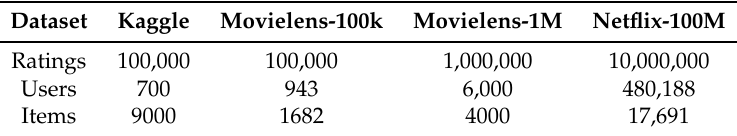
Table 2. Datasets used to test PMF and BNMF algorithms.